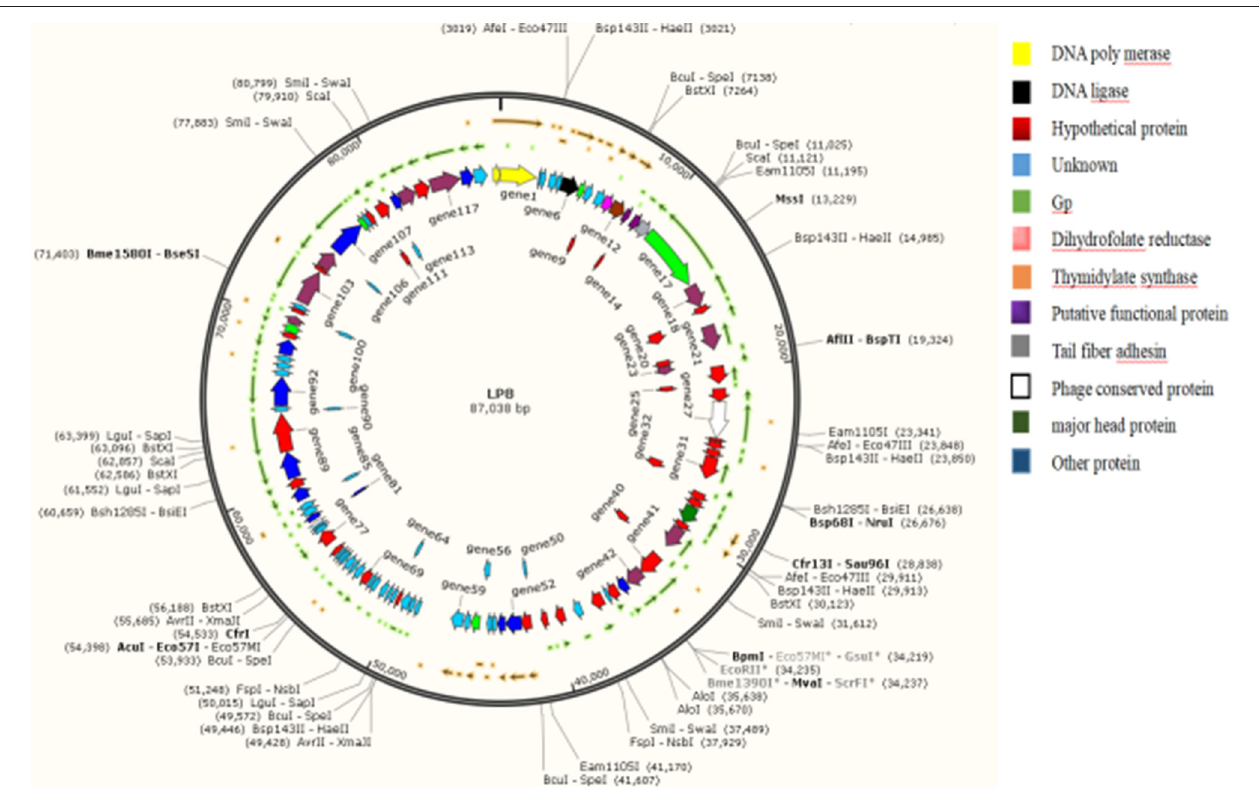
FIGURE 4 | Whole-genome map of LP8. Length of the phage LP8 genome is 87,038 bp, with a total of 120 coding genes. Length of the coding region accounts for 87.69% of the genome length. Six genes encode proteins involved in phage synthesis, 20 genes encode proteins involved in phage-related biological processes, and 11 genes encode proteins involved in molecular functions such as binding or